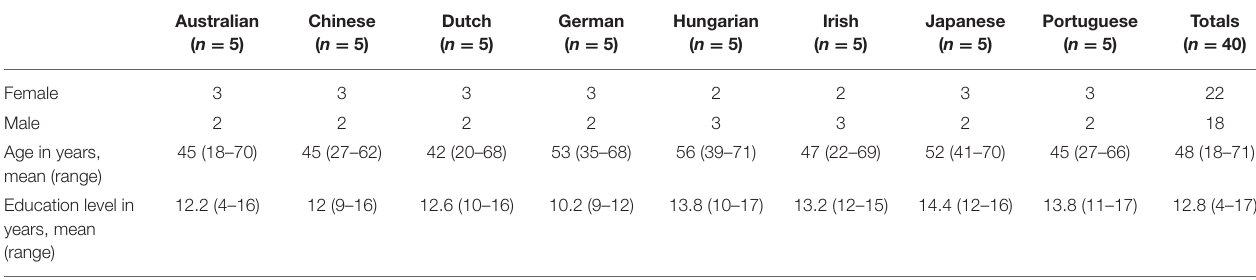
TABLE 2 | Participant characteristics; cognitive